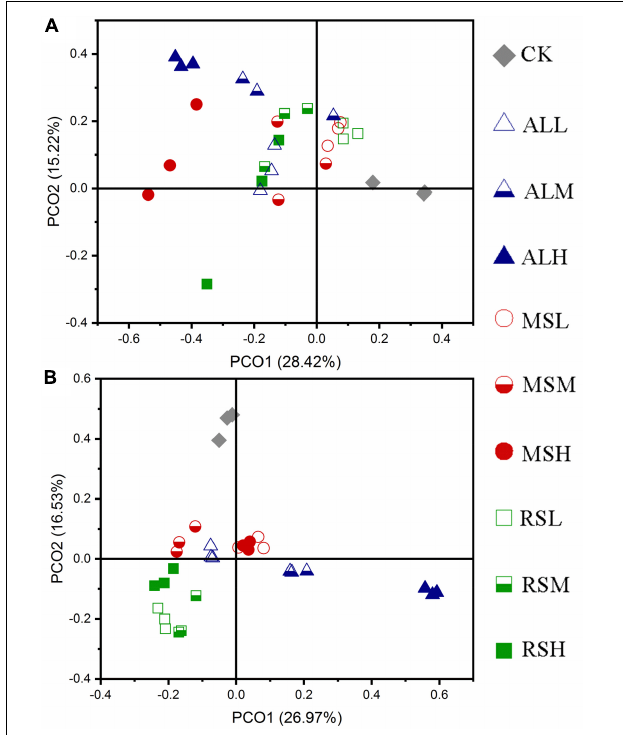
FIGURE 7 | Principal coordinate analysis for the dissimilarities of fungal microbial communities in different soils. (A,B) Day 21 and after tomato planting, respectively. PCoA of fungi based on the bray_curtis